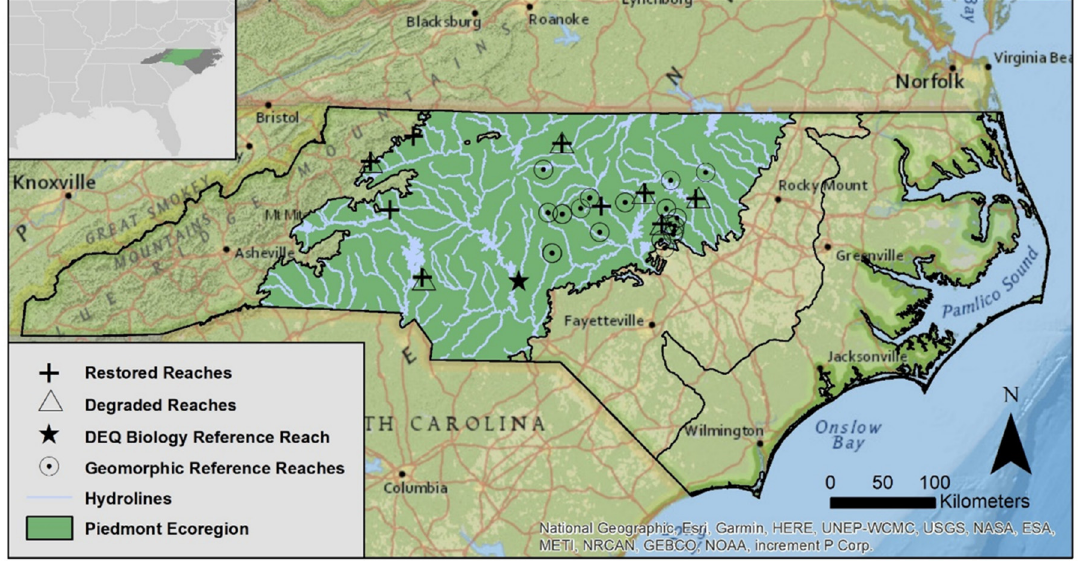
Figure 2. Location of 34 stream assessment sites in the Piedmont ecoregion, NC (Southeast, USA). Table 1. Select attributes for restored (n = 9), degraded (n = 6), geomorphic reference (n = 18) study sites and the biological reference (n = 1) study site located in the Piedmont ecoregion, NC (Southeast, USA).